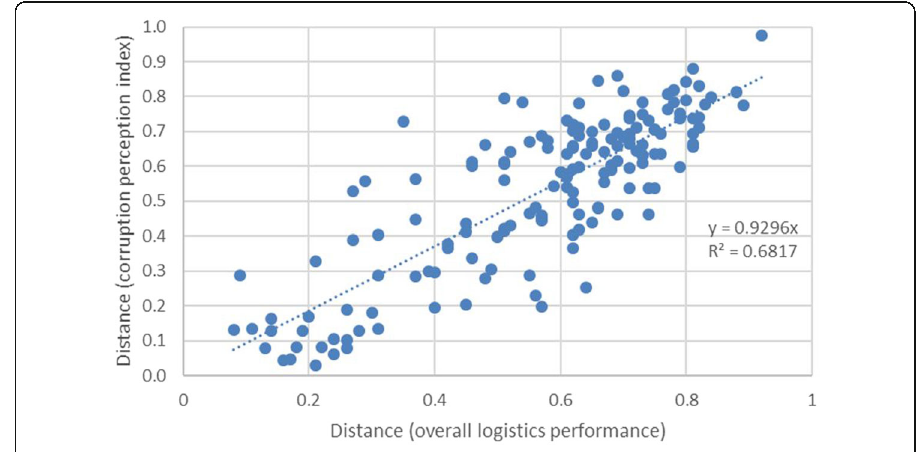
Fig. 18 Correlation between CPI and logistics definition of